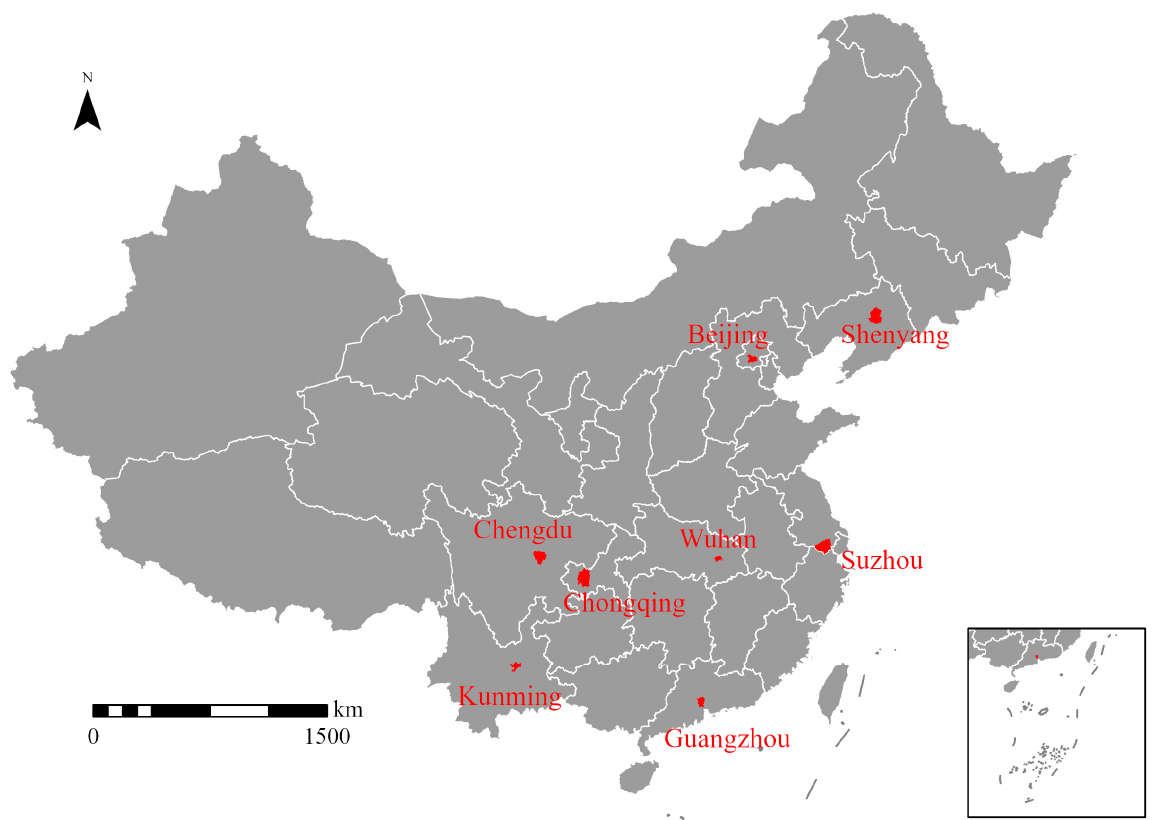
Figure 2. Location of the eight megacities (Beijing, Chengdu, Chongqing, Guangzhou, Kunming, Shenyang, Suzhou, and Wuhan) in China.